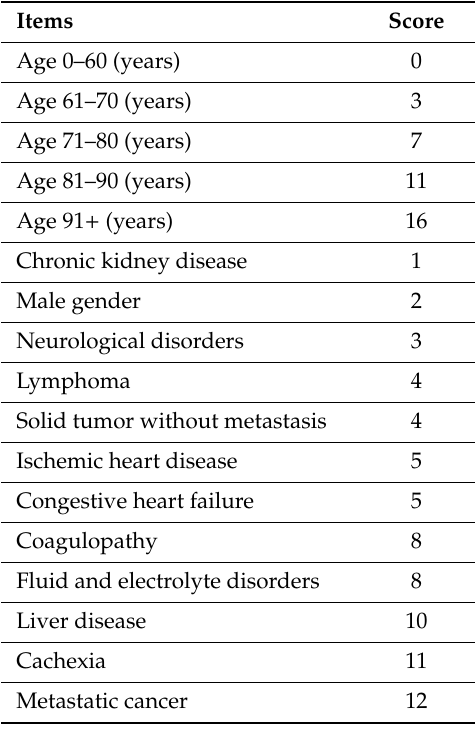
Table 1. Points assigned to di ff erent conditions in order to calculate the score for risk of in-hospital mortality